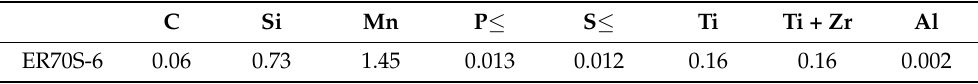
Figure 5. Stress–strain curve of ER70s-6. Table 2. Chemical composition of